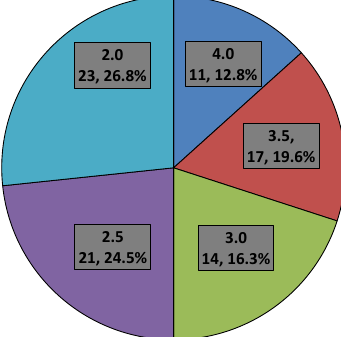
Figure 5. Pie chart showing percentage values of article in each category of the quality assessment (i.e., Quality assessment score, number of articles, and percentage